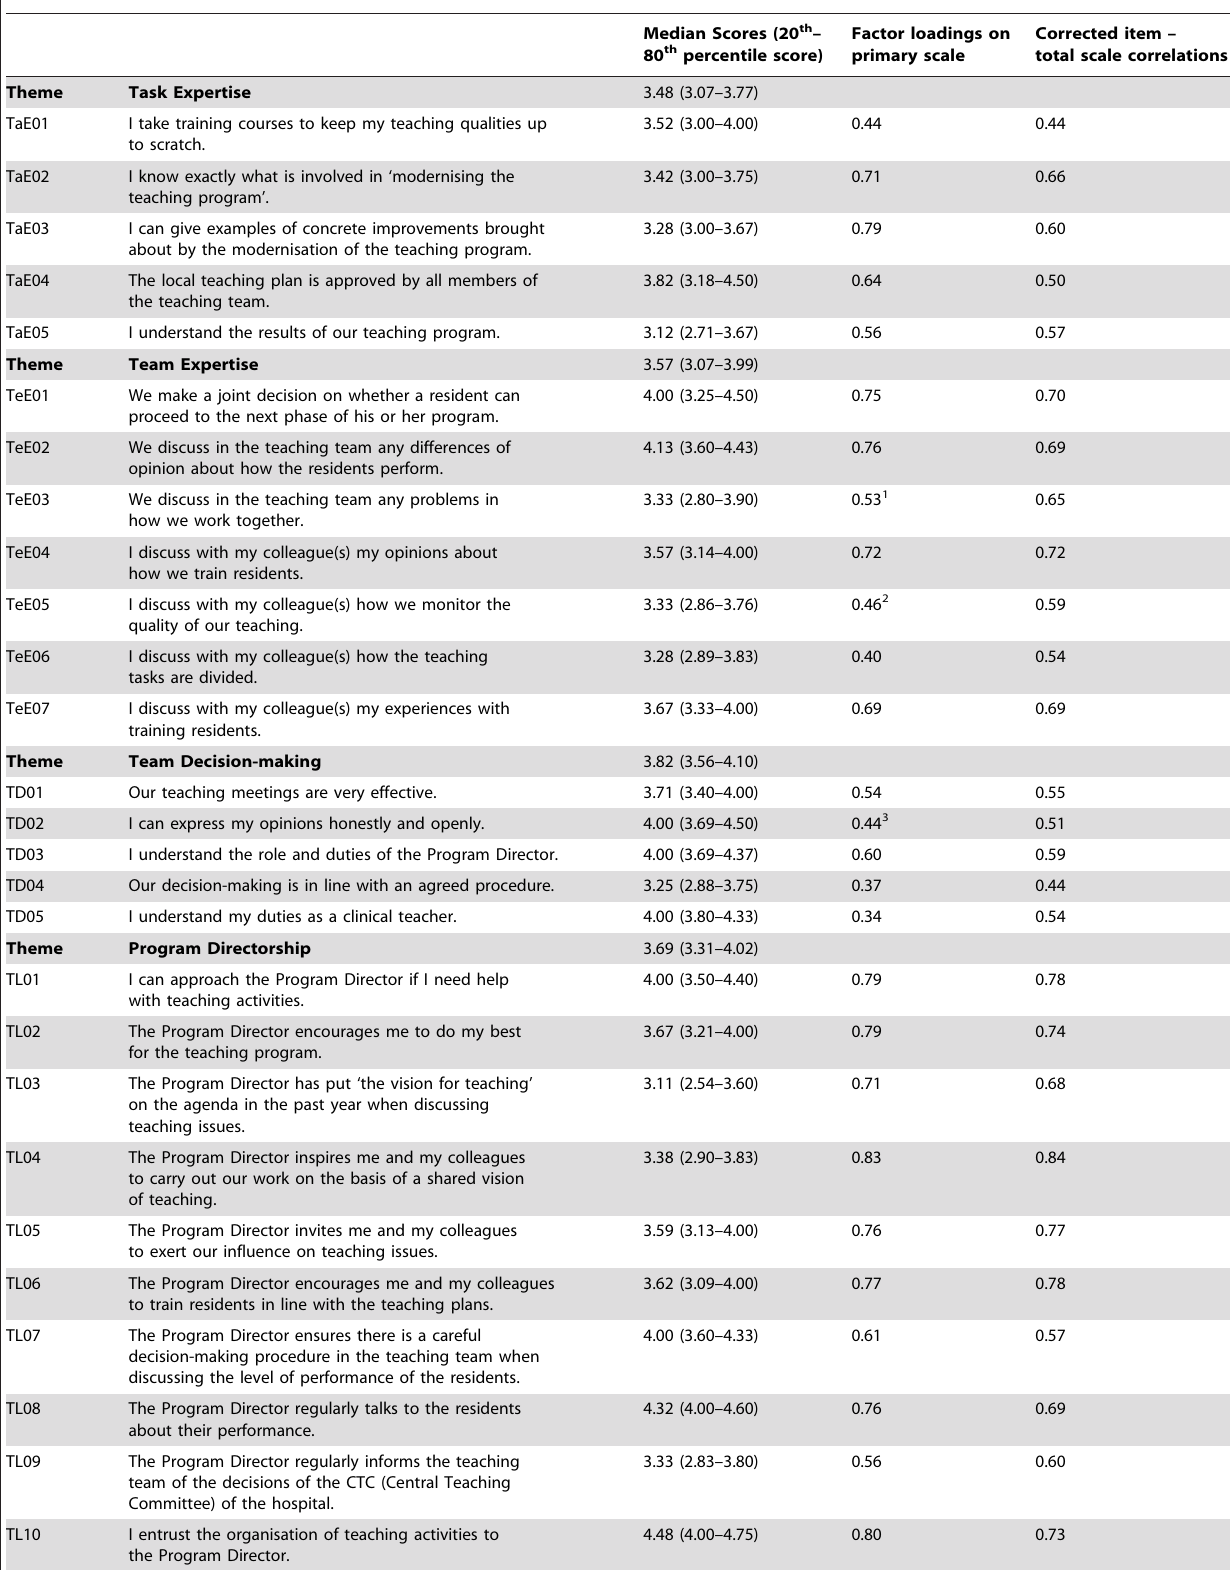
Table 3. Median scores, factor loadings and corrected item-total scale correlations, for the TeamQ